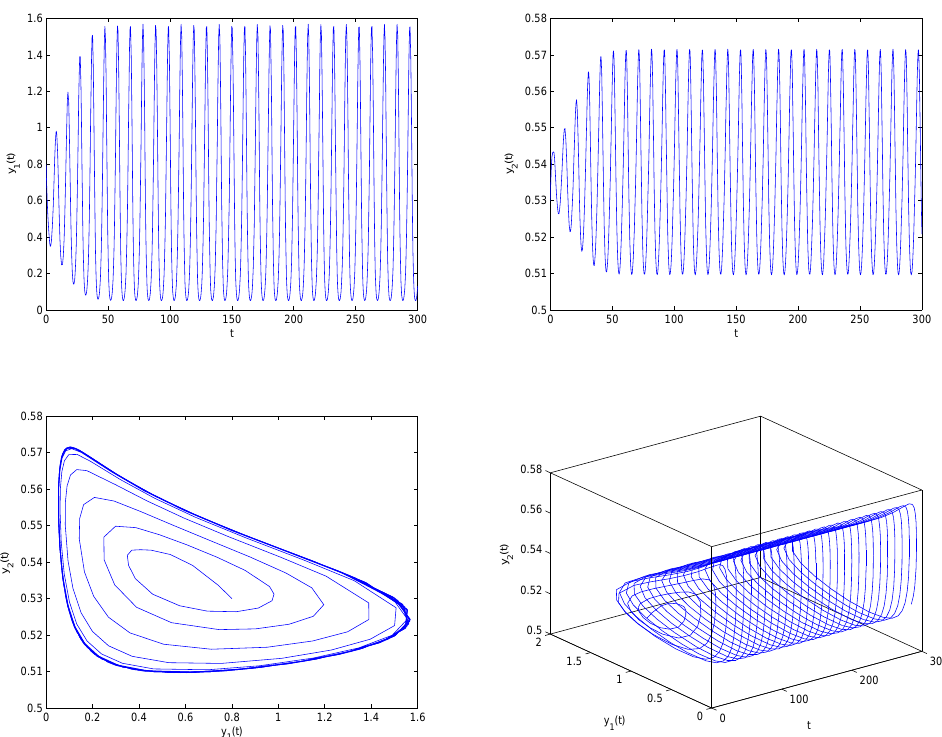
Figure 2. Numerical simulation results of model (62) concerning θ = 1.94 > θ 0 = 1.7. Hopf bifurcation appears near the positive equilibrium point Y ( 1.0221,16.0947 ).